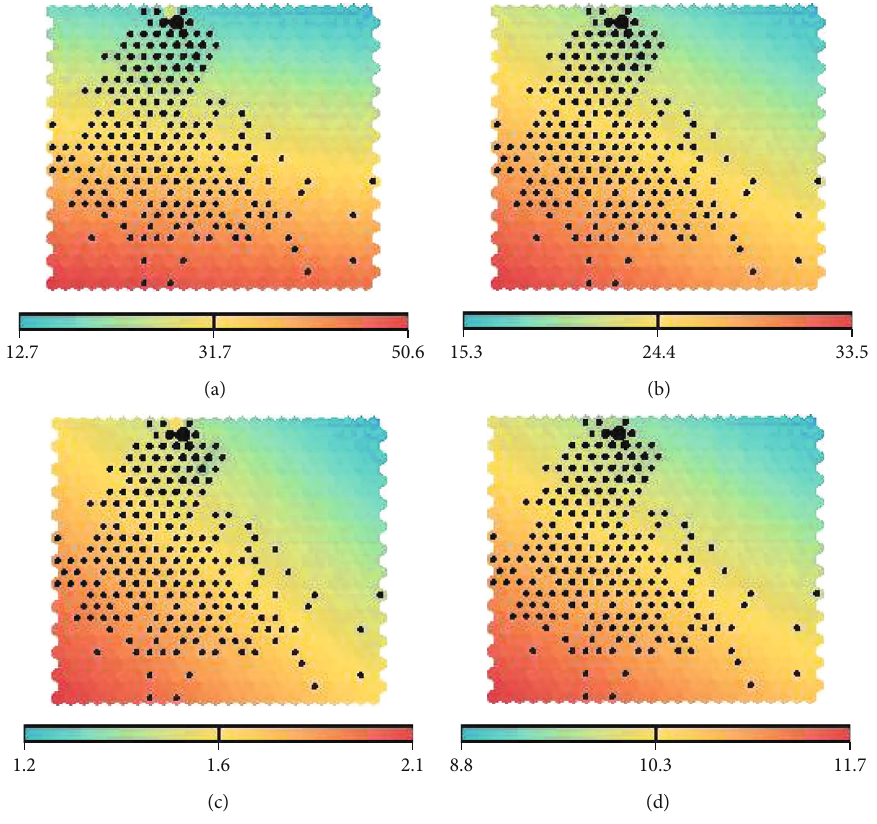
0 ; (b) L ; (c) D 1 ; (d) V .